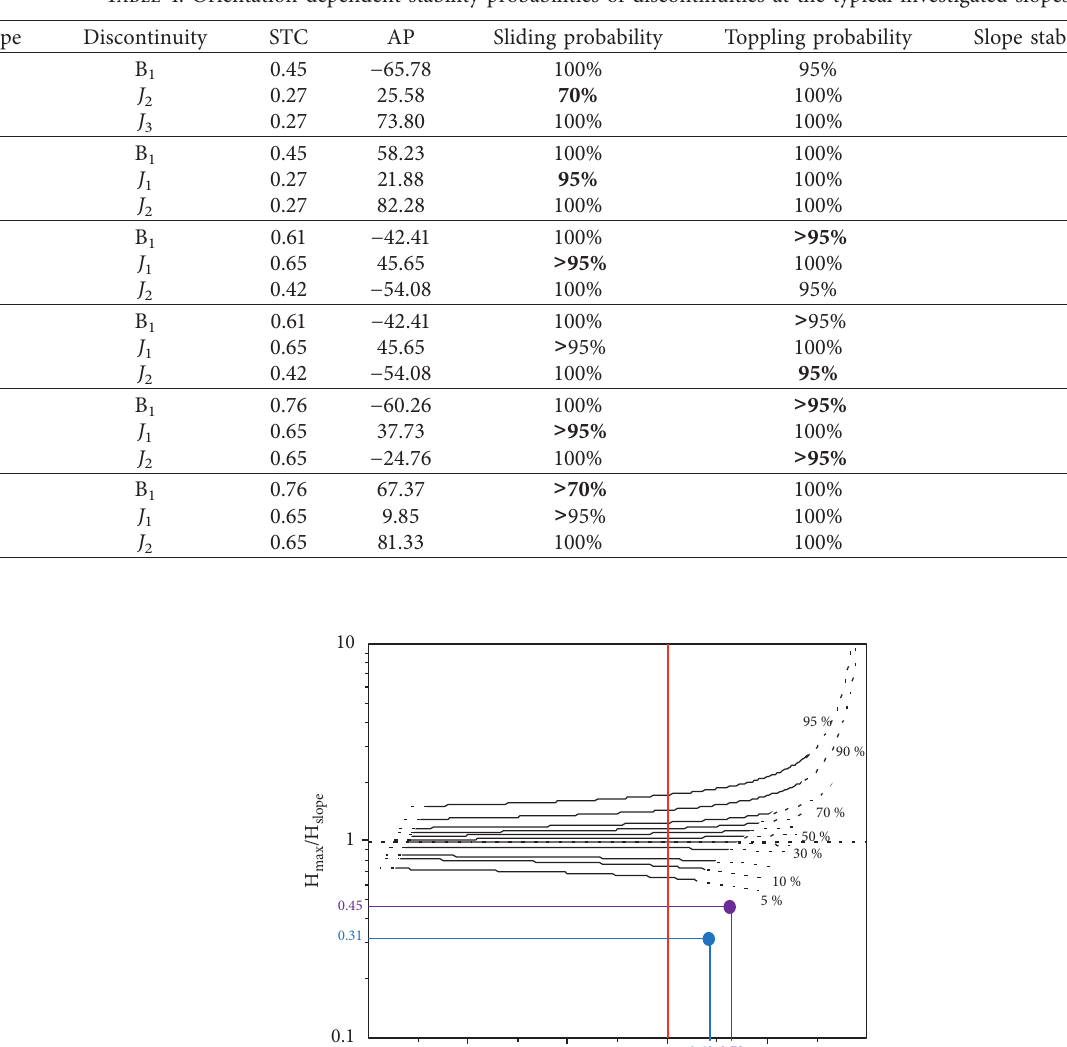
Figure 7: Flowchart of the SSPC methods determined by sliding and toppling (slope 1). (a) Sliding. (b) Toppling. Table 4: Orientation-dependent stability probabilities of discontinuities at the typical investigated slopes.